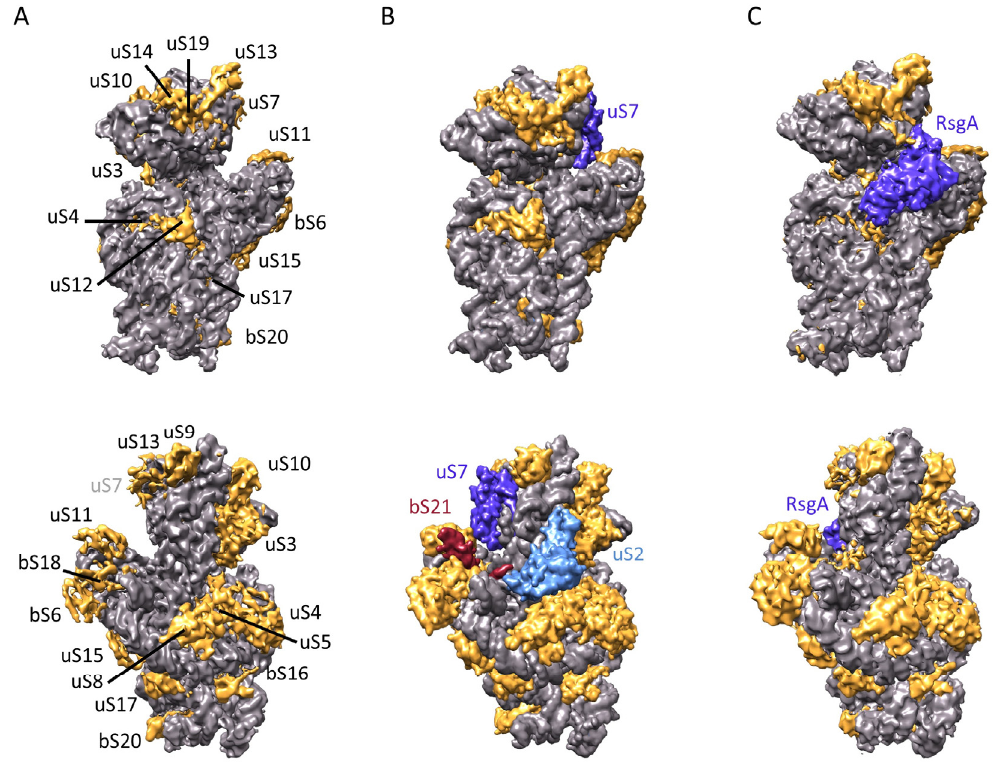
Figure 6. Structural comparison of 21S and 30S ribosomal subunits. ( A ) Front (top) and back (bottom) views of the 21S from this study, with the density corresponding to the rRNA in grey, and the ribosomal proteins highlighted in gold. Note that the density of uS7 is poorly defined. ( B ) Same views, but here of an atomic model of the E. coli 30S ribosomal subunit (PDB 4V4Q) filtered to adjust the resolution to match the 21S map. The ribosomal proteins uS2 and bS21, missing in our 21S structure, are light blue and red, while the uS7 is blue. ( C ) Same, but for the 30S + RsgA cryo-EM map (EMD-3663), with the RsgA maturation factor in blue.